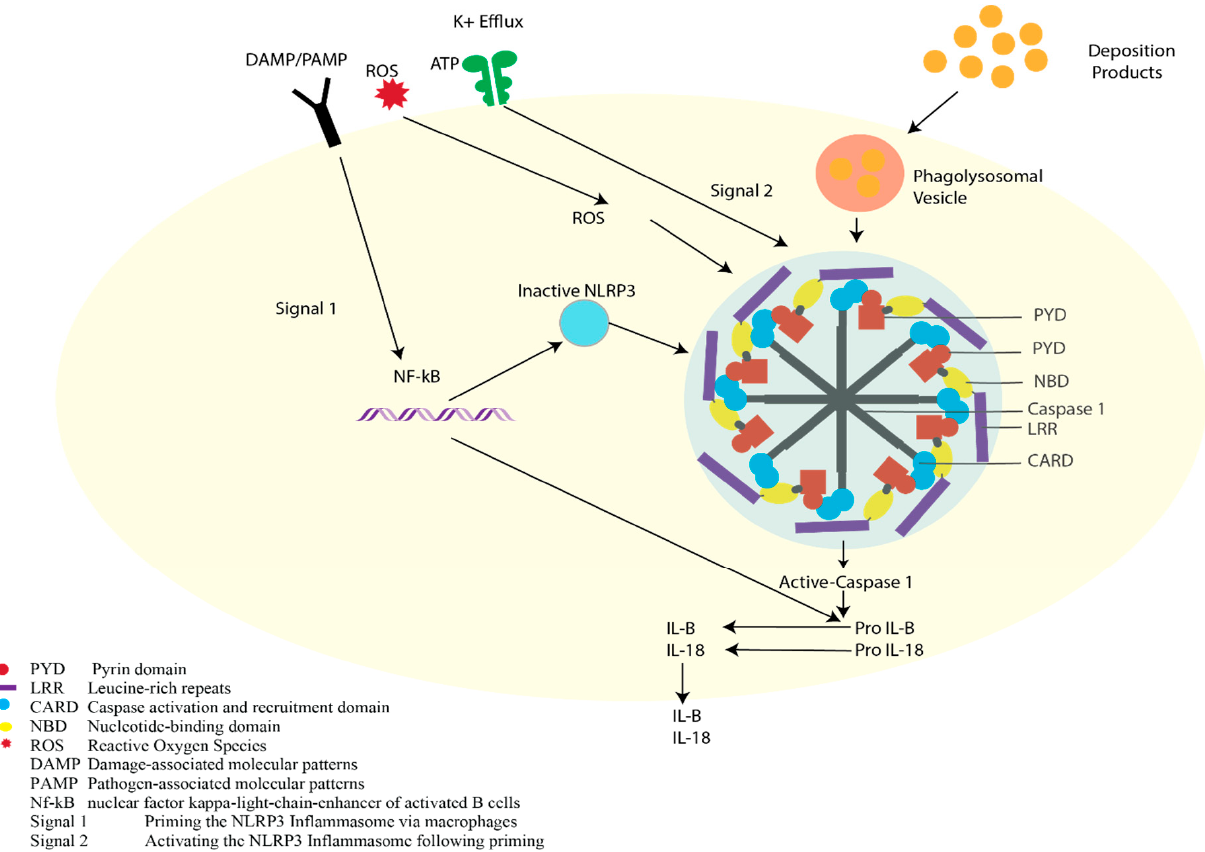
Figure 3. NLRP3 inflammasome [116].